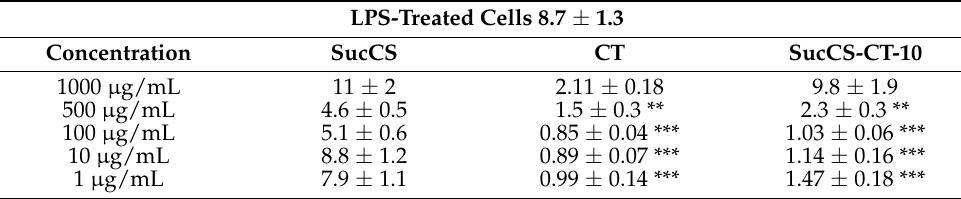
Table 5. Effects of SucCS-CT-10 conjugate on LPS-induced CD54 expression of THP-1 cells. Data are presented as mean ± SD ( n ≥ 6); the data are shown as CD54